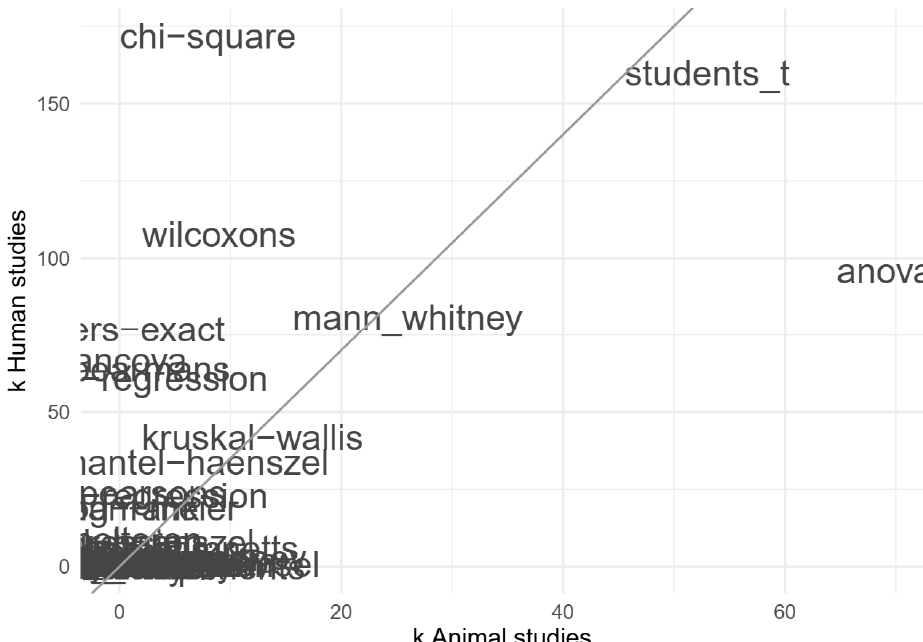
Figure 8. Impression of the reported frequencies of specific statistical analyses in animal and human studies; e.g., the ANOVA (analysis of variance test) was reportedly used in 69 animal studies (on the x-axis) and 96 human studies (on the y-axis). The illegible part in the lower-left corner reflects a large number of rare analyses that are not particularly relevant. The diagonal line reflects the ratio of included human vs. animal studies.